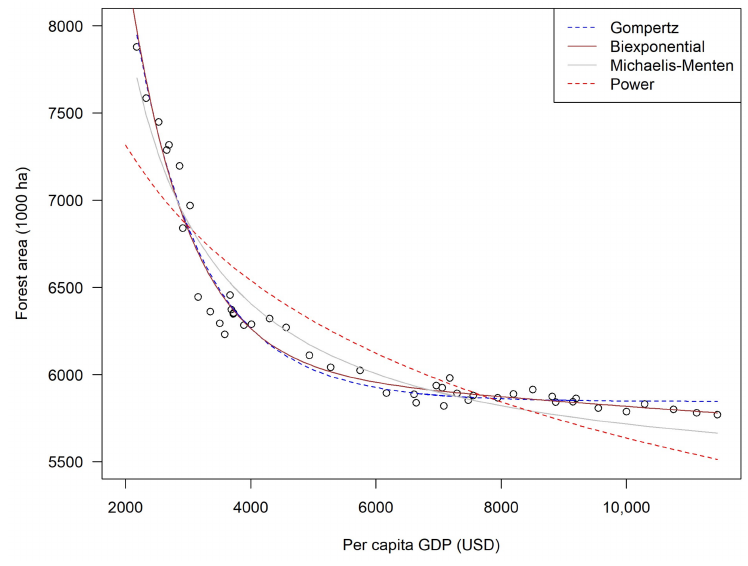
Figure 6. Curve fitting by other parametric